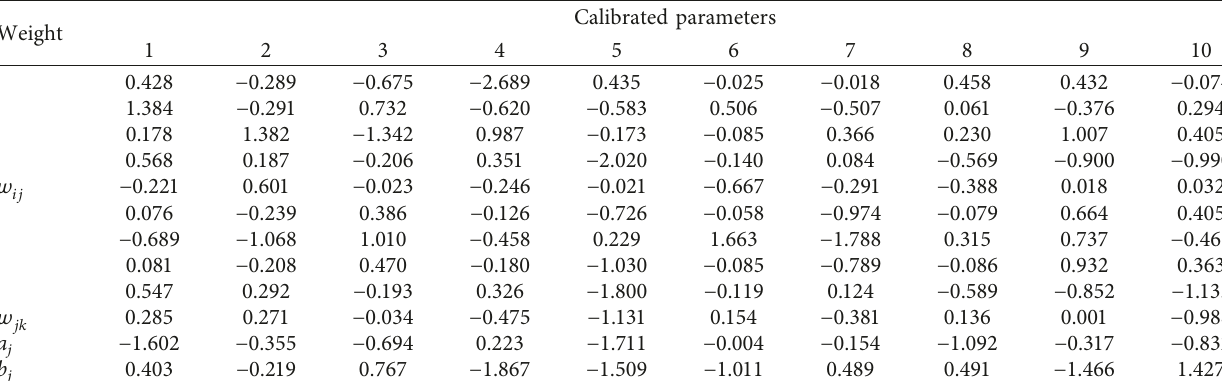
Figure 4: Fitness curves of WNN and IPSO-WNN models: (a) WNN model (maximum evolution � 1000); (b) IPSO-WNN model (maximum evolution � 500). Table 2: Calibrated parameters of the IPSO-WNN model.